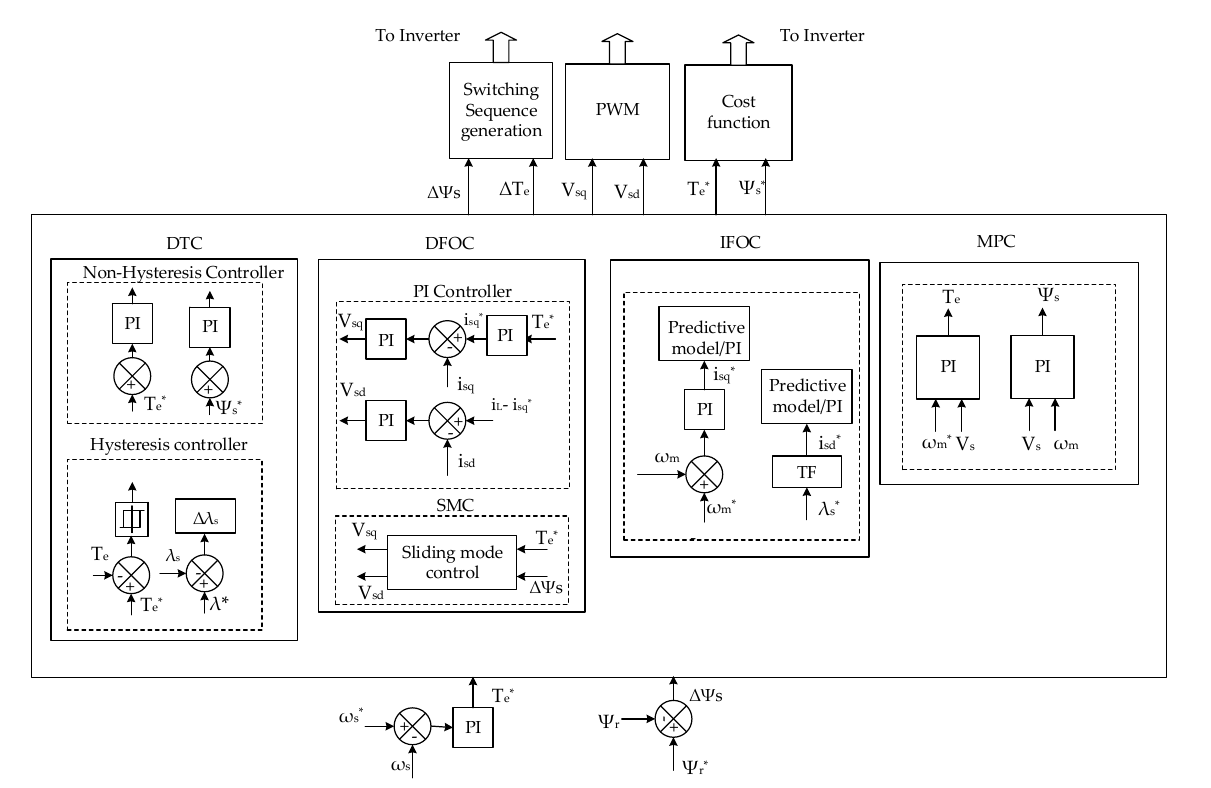
Figure 3. Control strategies for PMSM-based EV system.